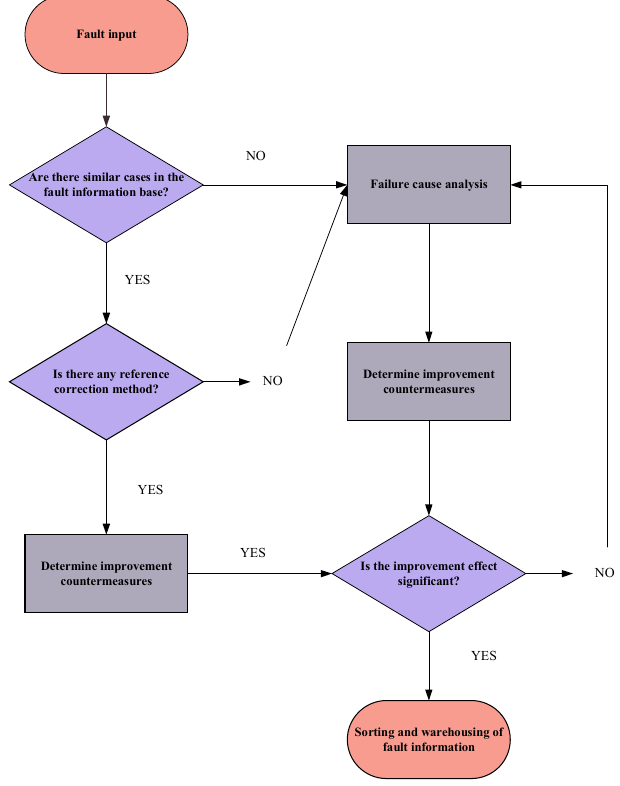
Figure 8. The FRACAS analysis process within 4F integration technology.